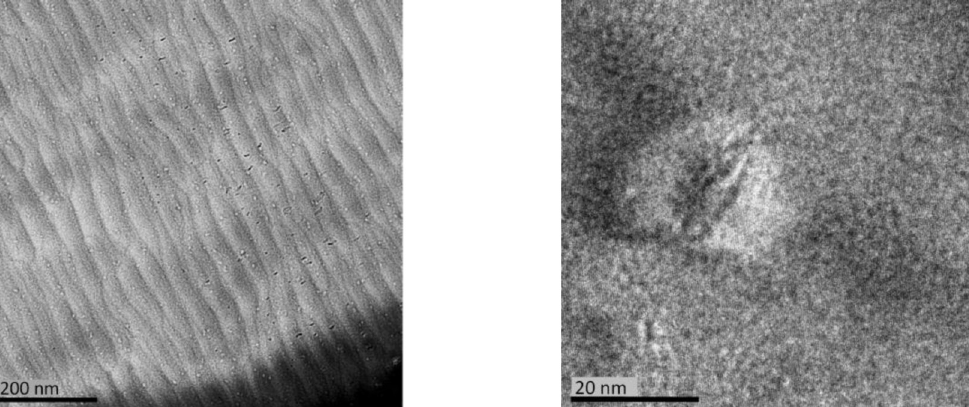
Fig. 10. 4 He implanted in B 4 C then annealed at 900 ° C. Left: intra-granular bubbles band (in black, the bubbles; riddles and white dots are artefacts due to FIB thinning). Right: strain fi eld around a bubble.